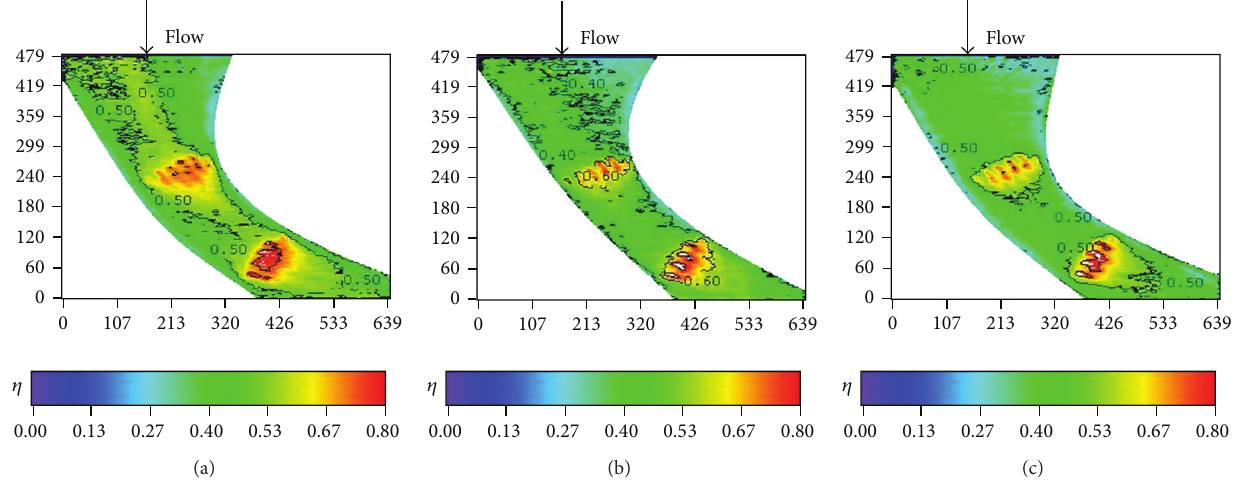
Figure 20: Effect of turbulence intensity on local effectiveness for forward-facing stepped endwall (Re = 124000 , 𝑀 = 2 , and 𝑆/𝐶 = 4 %). (a) T . I . = 1.8 %. (b) T . I . = 7 %. (c) T . I . = 12 %.